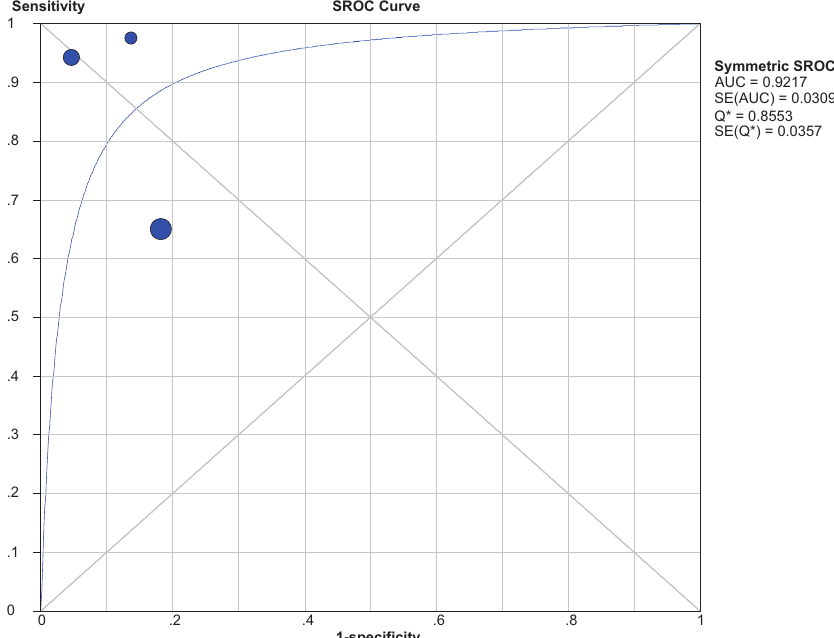
Figure 3. Summary receiver operating characteristics (SROC) curve for the diagnosis of BC through circulating